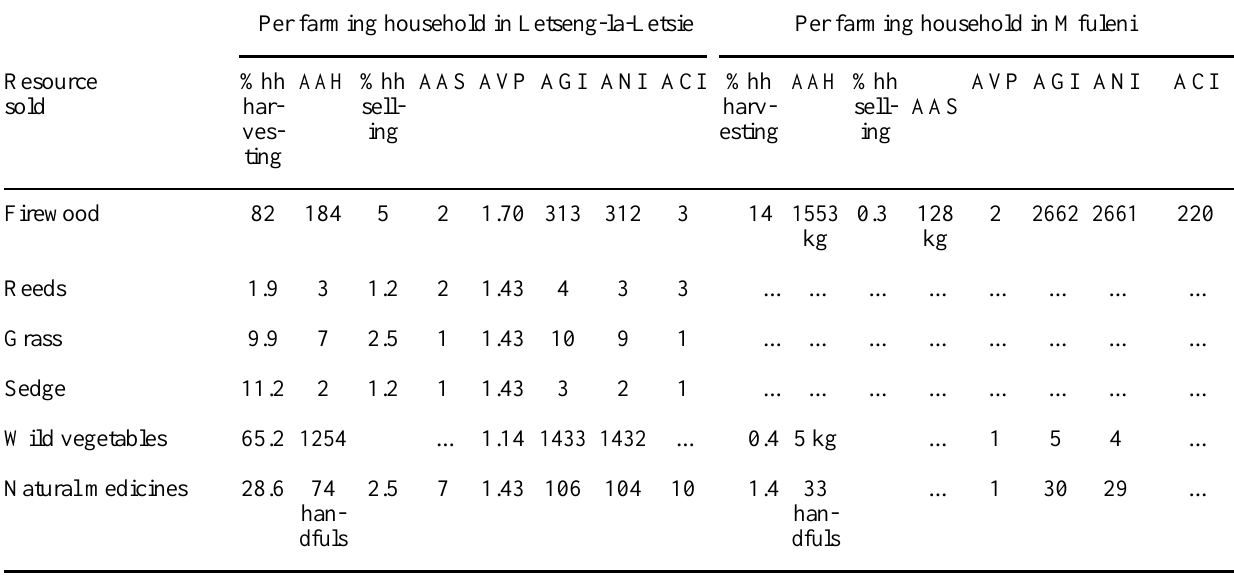
Table 3 . Average incomes from natural resources around Letseng-la-Letsie and Mfuleni over the previous year. Harvested units are head bundles for all but wild vegetables and medicines, which are measured as handfuls. %hh = percentage of households, AAH = average amount harvested the previous year, AAS = average amount sold, AUP = average unit price in U.S. dollars, AGI = average gross income per year in U.S. dollars, ANI = average net income per year in U.S. dollars, and ACI = average cash income per year in U.S.